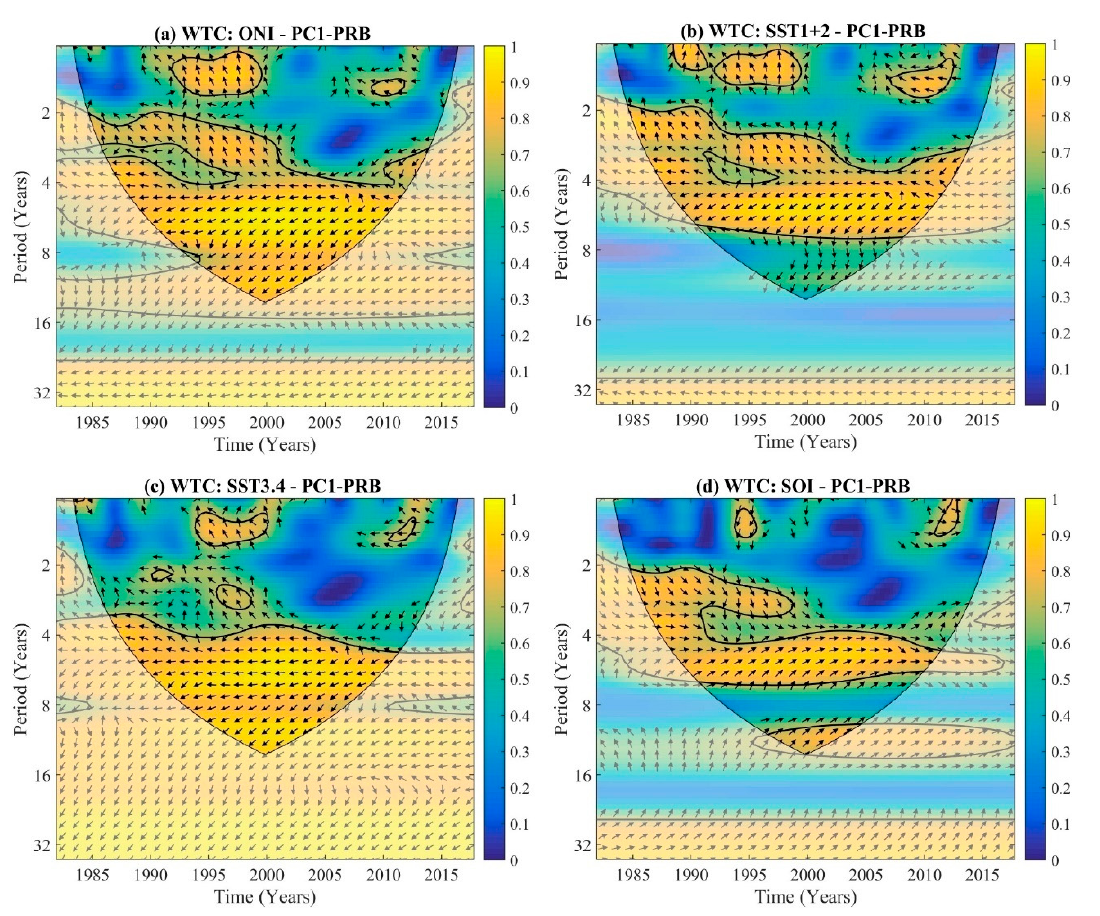
Figure 9. Wavelet coherence and phase differences between the PC1 series at PRB and ( a ) ONI ( b ) SST1 + 2; ( c ) SST3.4, and ( d ) SOI. As in Figure 8.